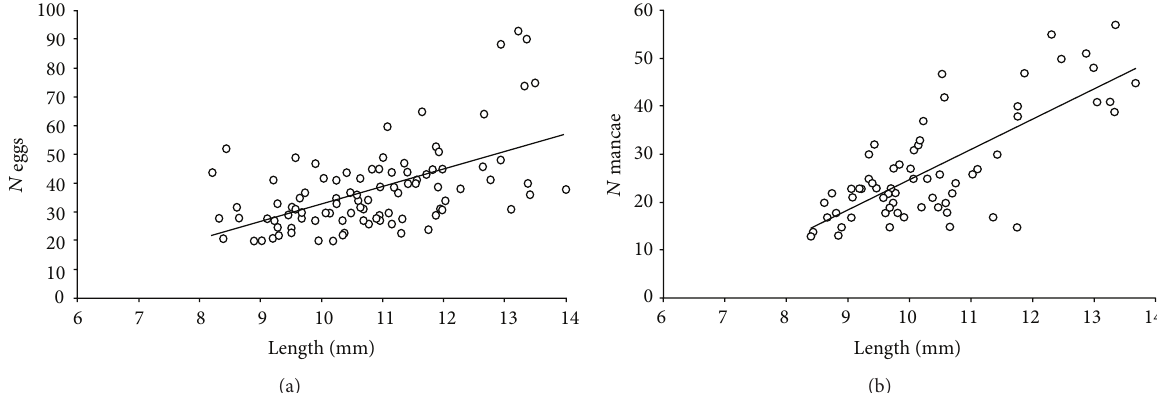
Figure 7: Relationship between the total size of ovigerous females of Monokalliapseudes schubarti and the number of: (a) eggs; (b) mancae ( 𝑁 =